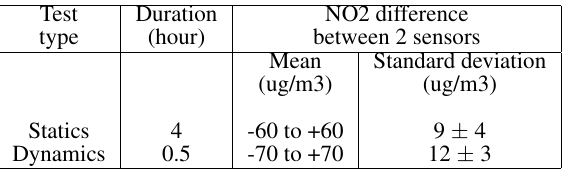
Table 3. NO2 concentration errors of the AirCrowd sensor node